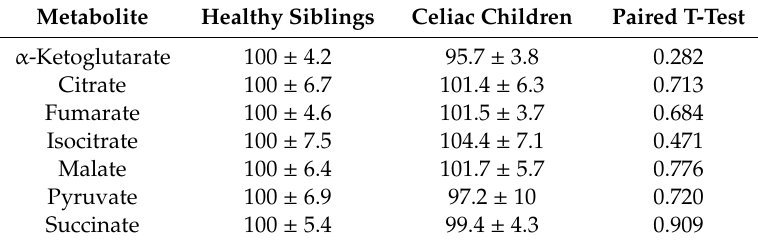
Table 3. Plasma energetic metabolism intermediates content in celiac patients and healthy siblings.